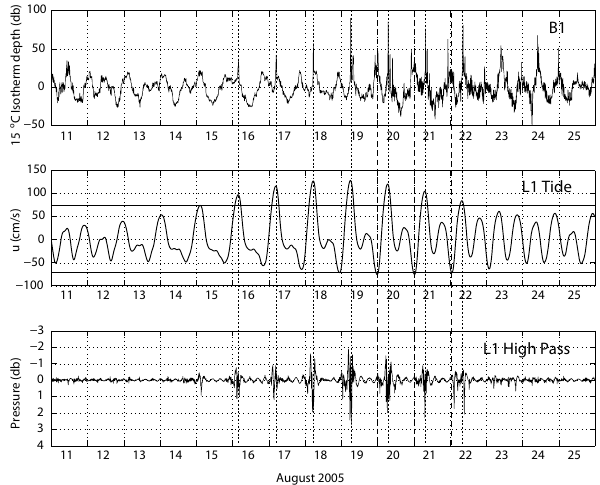
Fig. 14. The 15 ◦ C isotherm displacements at mooring B1, lagged back 33h to account for the propagation time from mooring L1 to B1 (top). The Foreman reconstruction of the tidal currents at mooring L1, using the vertically averaged data (middle). The high- passed pressure data from mooring L1, 410m depth (bottom). The vertical dotted lines indicate the time of a-wave arrivals at mooring B1, and the dashed lines are the b-wave arrivals. The horizontal lines on the middle panel indicate plus or minus 71cms − 1